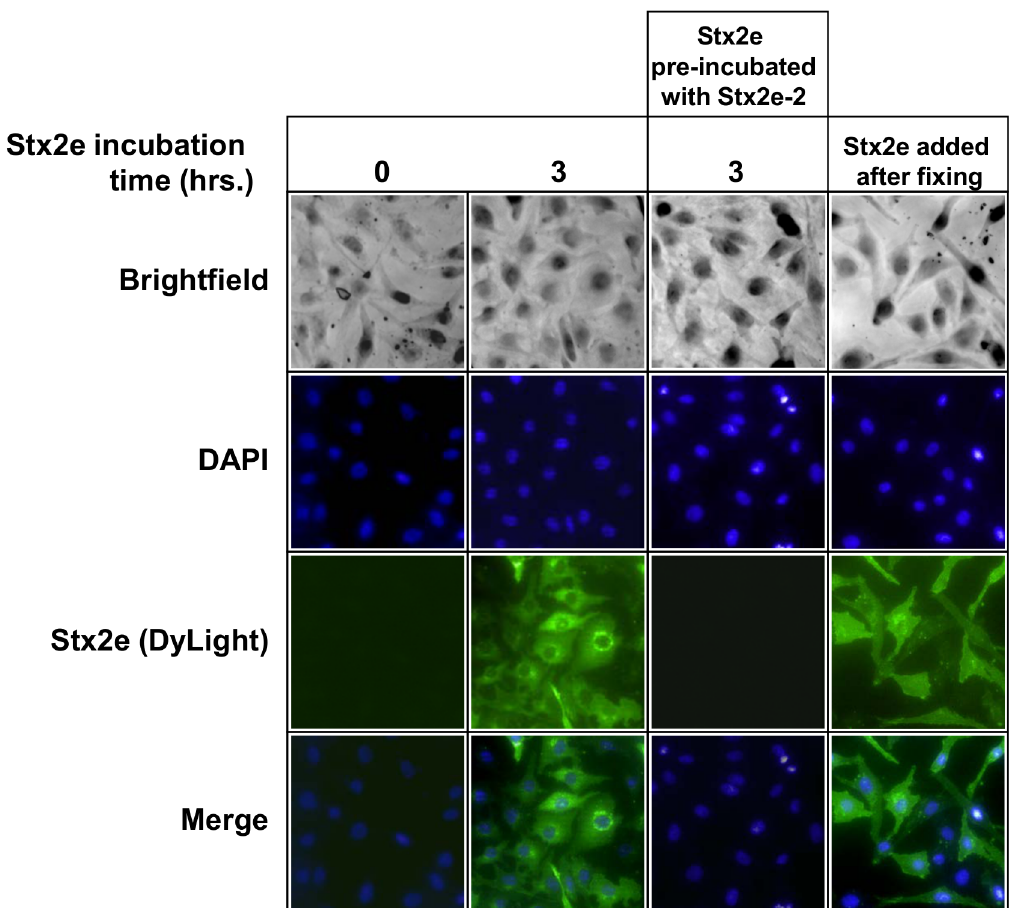
Fig 5. Immunofluorescence of Stx2e (E167Q) in Vero cells. mAb Stx2e-3 (1 μ g/mL) was used to visualize Stx2e (E167Q) (1 μ g/mL) in Vero cells. Stx2e (E167Q) was pre-incubated with either neutralizing mAb Stx2e-2 in media or media alone before adding to Vero cells. Cells were either fixed in paraformaldehyde before Stx2e (E167Q) treatment or after a 0 or 3 hour incubation with Stx2e (E167Q). After fixing and Stx2e (E167Q) treatment, the cells were blocked with BSA, incubated with mAb Stx2e-3, then incubated with anti-mouse DyLight (green images) and DAPI (to stain nuclei, blue images).